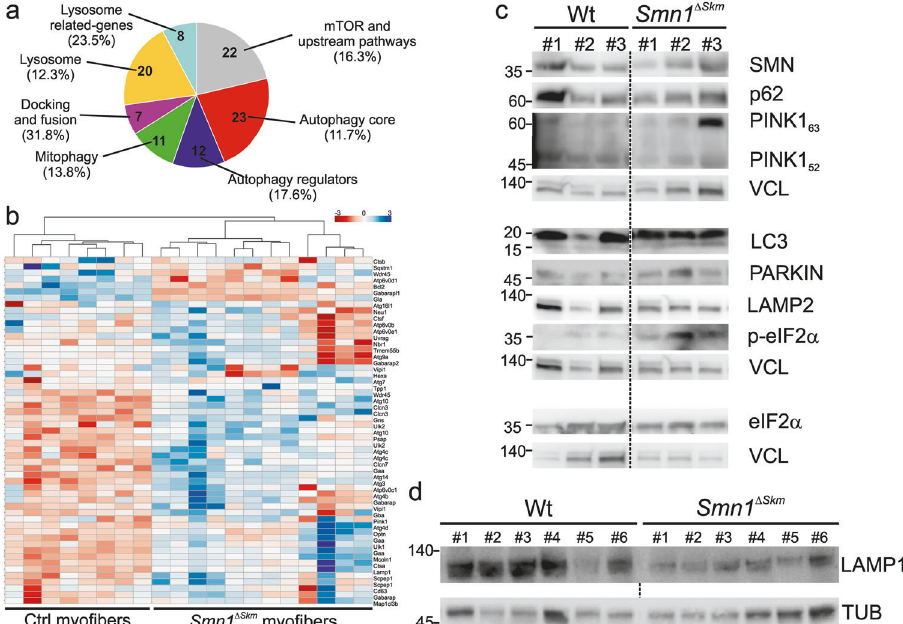
Fig. 6 SMN loss in skeletal muscle causes autophagy dysregulation. a Pie chart of differentially expressed genes belonging the 6 main groups of the autophagic list [57] in Smn1 Δ Skm myo fi bers. The percentages indicate the proportion of the genes differentially expressed in Smn1 Δ Skm myo fi bers over the number of genes belonging to each category as de fi ned in [57]. b Heat map of expression levels of genes related to autophagy activation and lysosomal biogenesis. Each column corresponds to a single myo fi ber of the indicated genotype. The dendrogram cluster myo fi bers with similar transcriptional signature. c , d Equal amounts of gastrocnemius muscle lysates (20 µg) were separated by SDS- PAGE and immunoblotted using the indicated antibodies. Each lane corresponds to an individual mouse of the indicated genotypes. Densitometry analysis yielded the following values: SMN: 1.16 ± 0.14 in Wt ( n = 4) and 0.77 ± 0.04 in Smn1 Δ Skm ( n = 5), p = 0.02; LC3II: 0.04 ± 0.01 in Wt (n = 4) and 0.11 ± 0.02 in Smn1 Δ Skm ( n = 5), p = 0.03; PINK: 0.79 ± 0.14 in Wt ( n = 4) and 1.6 ± 0.29 in Smn1 Δ Skm ( n = 4), p = 0.04; PARKIN: 0.14 ± 0.02 in Wt ( n = 4) and 0.8 ± 0.17 in Smn1 Δ Skm ( n = 4), p = 0.01 p-eIF2 α / eIF2 α ː 0.19 ± 0.02 in Wt ( n = 4) and 0.4 ± 0.05 in Smn1 Δ Skm ( n = 4), p = 0.01; LAMP2 Wt 0.79 ± 0.11 in Wt ( n = 5) and 0.48 ± 0.03 in Smn1 Δ Skm ( n = 7), p = 0.013; and LAMP1: 0.75 ± 0.14 in Wt ( n = 6)